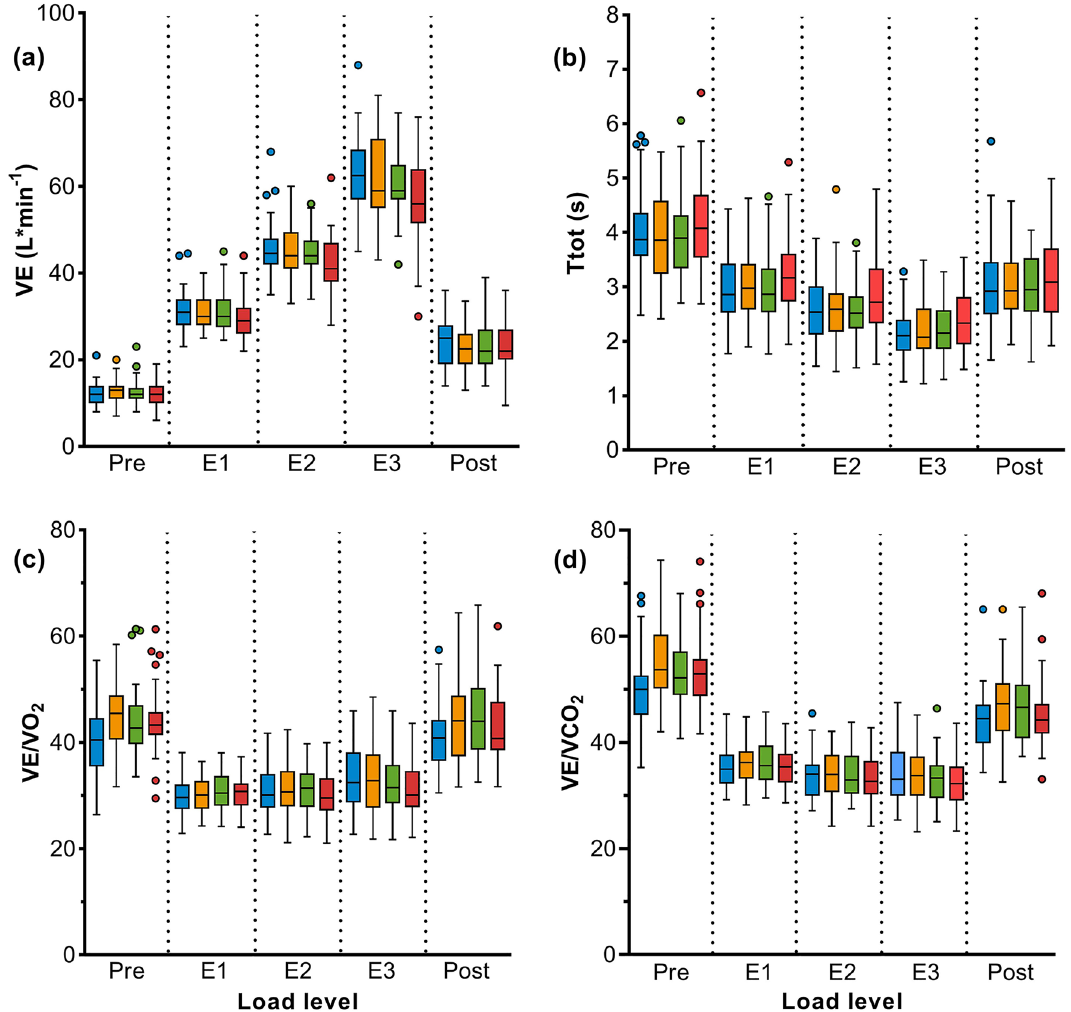
Figure 2. Cardiopulmonary exercise test measurement: Results of ( a ) minute ventilation (VE), ( b ) inspiratory and expiratory time (Ttot), ( c ) ventilation per litre of oxygen (VE/VO 2 ), and ( d ) ventilation per litre of carbon dioxide (VE/VCO 2 ) in 40 subjects without mask (blue), with surgical mask (yellow), community mask (green), and FFP2 (red). The load levels correspond to light work (pre and post), moderate (E1), heavy (E2) and very heavy work (E3). P-values are shown in Table